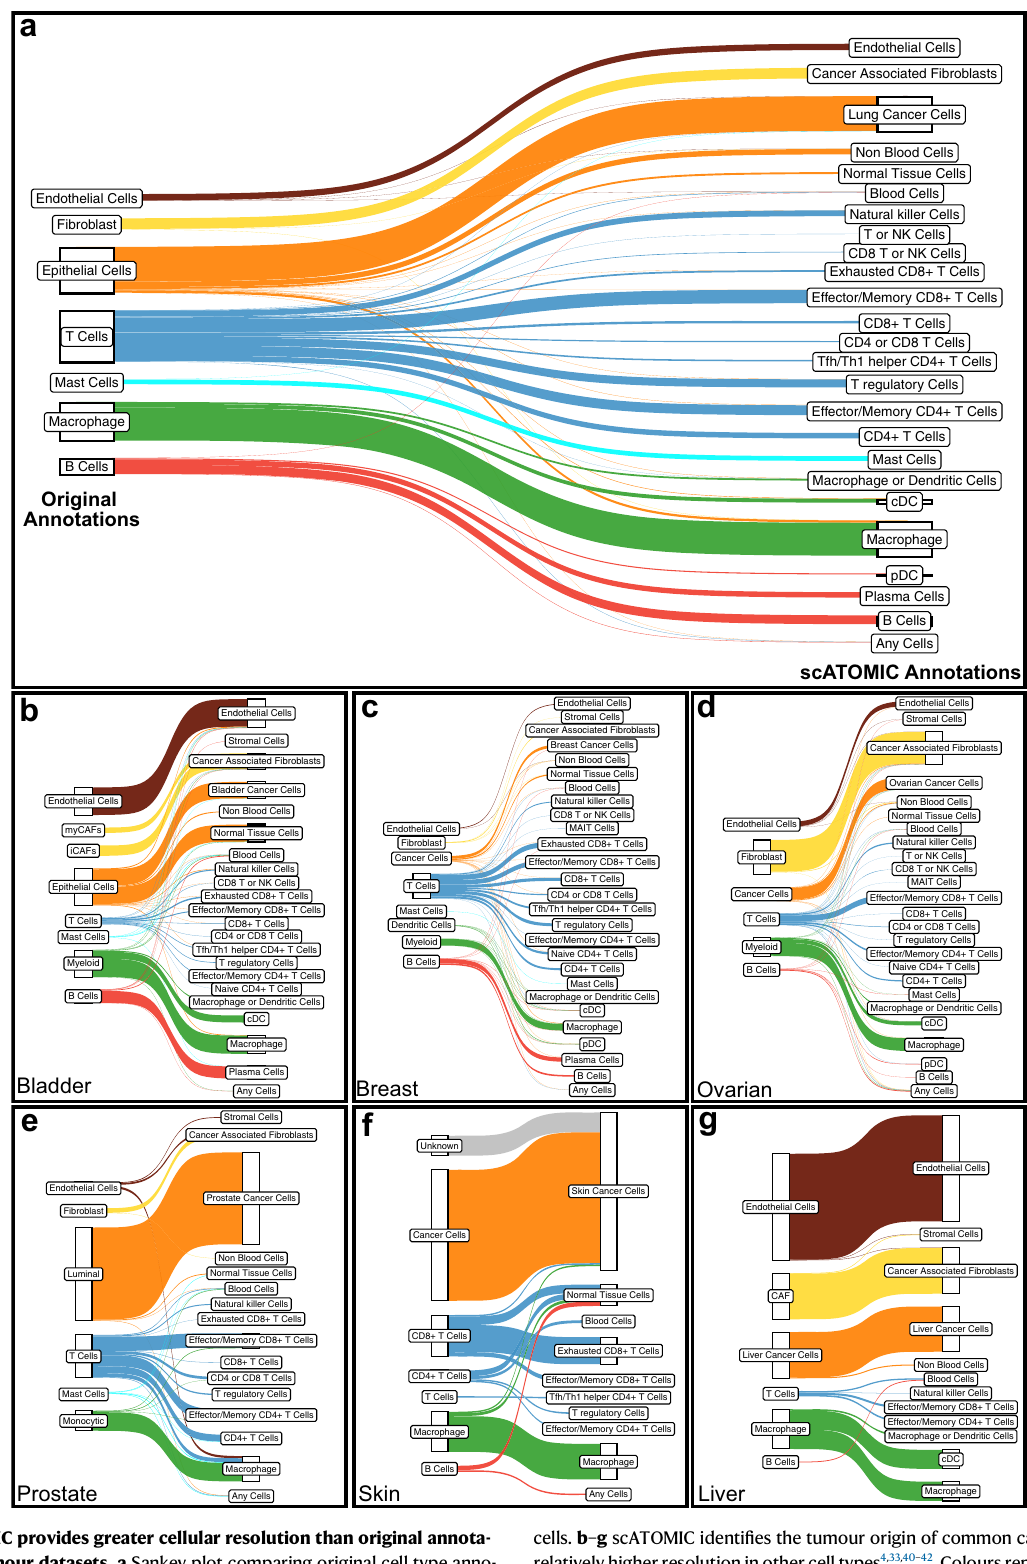
cells. b – g scATOMIC identi fi es the tumour origin of common cancers and deliver relativelyhigherresolutioninothercelltypes 4,33,40 – 42 .Coloursrepresenttheoriginal reported annotations associated with each dataset. The height of each block represents the relative number of cells that received a respective annotation. Source data are provided as a Source Data fi